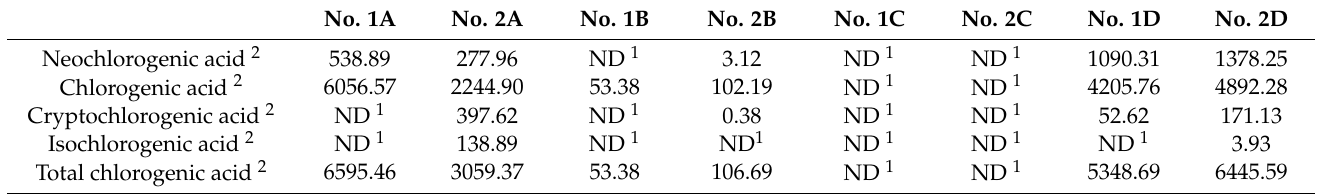
Table 6. The total and individual chlorogenic acid contents of the four solvent extracts of two varieties of Hang